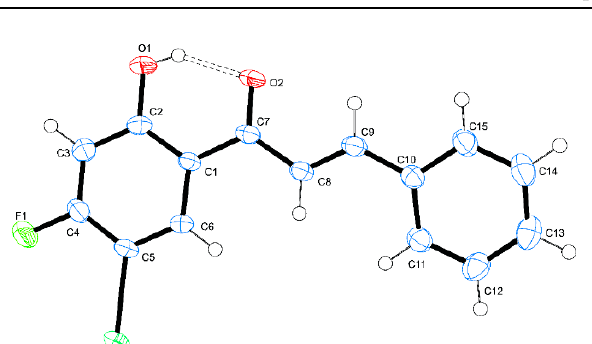
Figure 1. Oak Ridge Thermal Ellipsoid Plot (ORTEP) diagram (50% probability level) of 2a . For clarity, hydrogen atoms are not labeled.